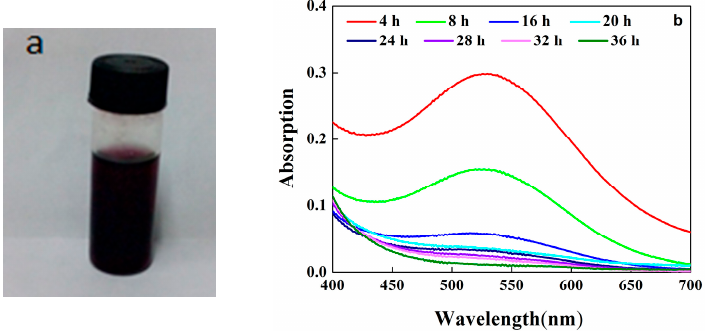
Figure 4. UV ‐ vis spectra monitoring the oxidation process under the catalysis of hematin ‐ MPTS ‐ M ‐ MWCNTs. ( a ) The liquid exhibited a purple ‐ black color after reaction; ( b ) UV ‐ vis spectra.